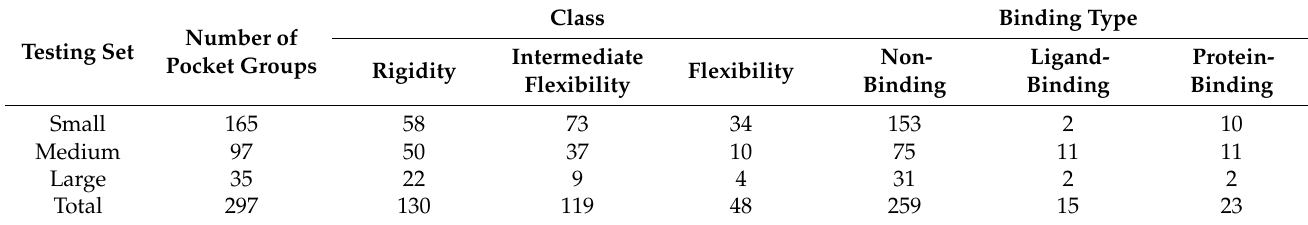
Table 2. The distribution of the classes of flexibility and binding types for pocket groups in Testing Sets